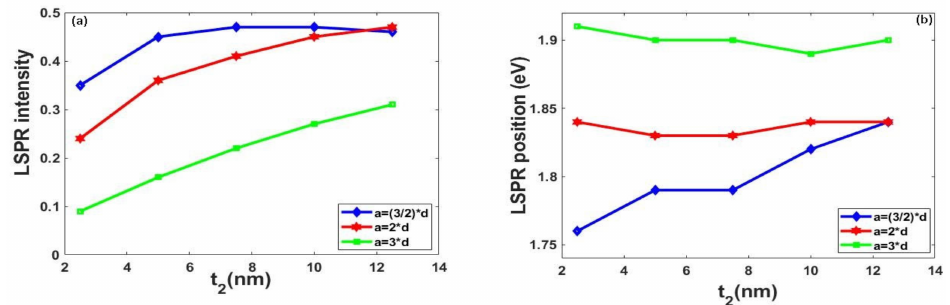
Figure 5. Size dependent LSPRs ( a ) intensity; ( b ) position for d = 5 nm–25